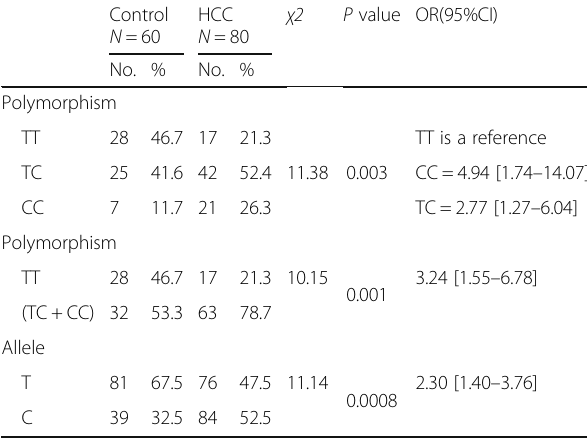
Table 4 Comparison of polymorphism between Control and HCC groups